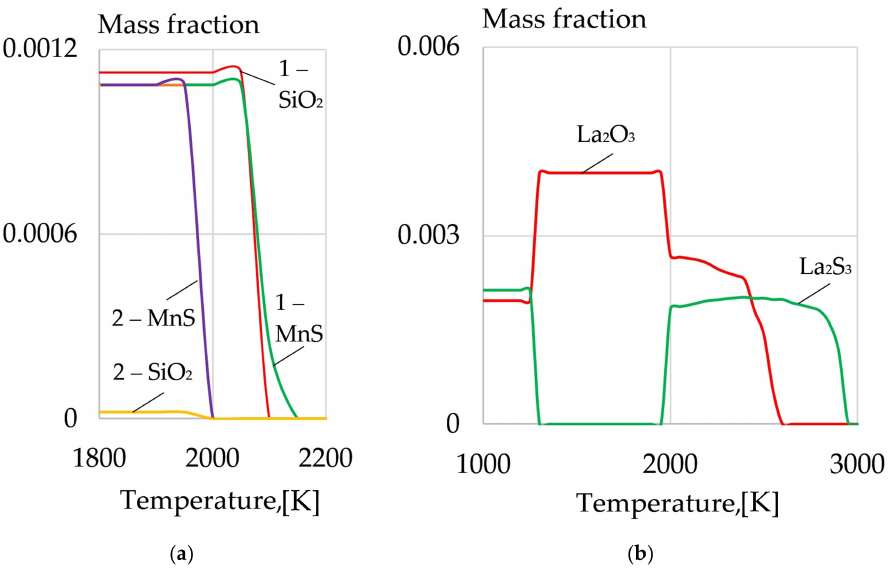
Figure 10. ( a ) The content of SiO 2 and MnS in 10HSND steel: (1) without REMs, (2) with addition of